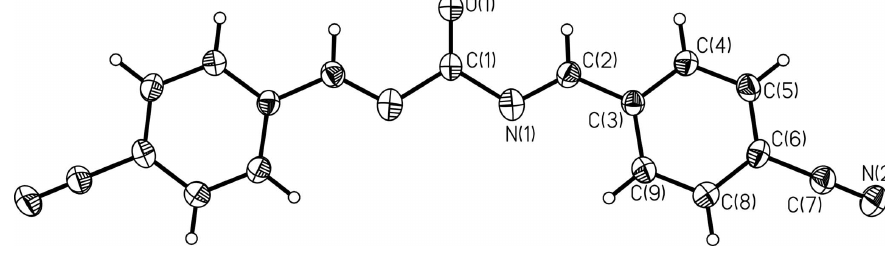
The molecular structure of the title compound, showing the atomic numbering scheme. Displacement ellipsoids are drawn at the 30% probability level. Unlabelled atoms are related to the labelled atoms by (- x , y , 1/2 - z